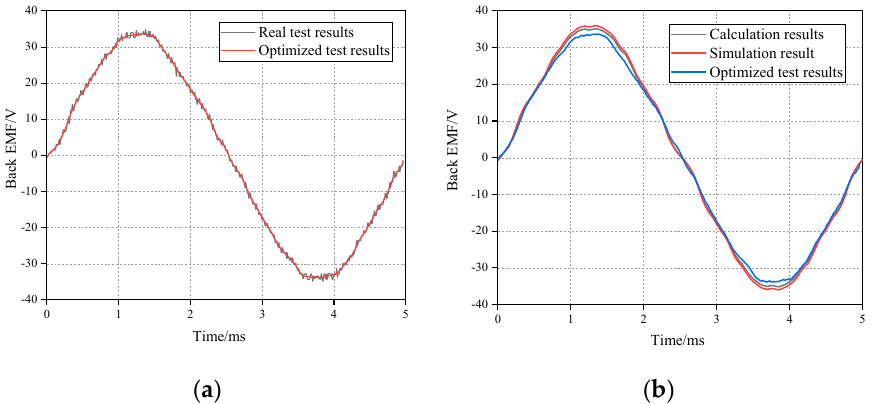
Figure 15. Comparison of back EMF curve of motor: ( a ) The real test results and the optimization test results; ( b ) the optimization test results, calculation results, and simulation results.